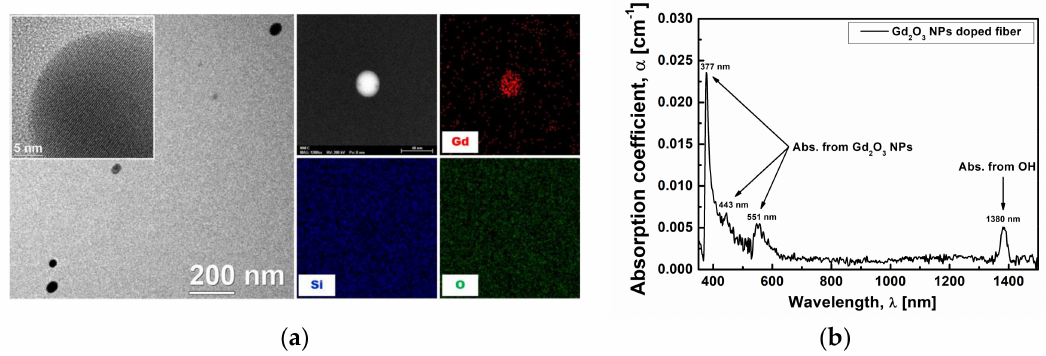
Figure 4. ( a ) TEM image with the EDS compositional maps for Gd, Si, and O and ( b ) absorption spectrum of the Gd 2 O 3 NPs-doped